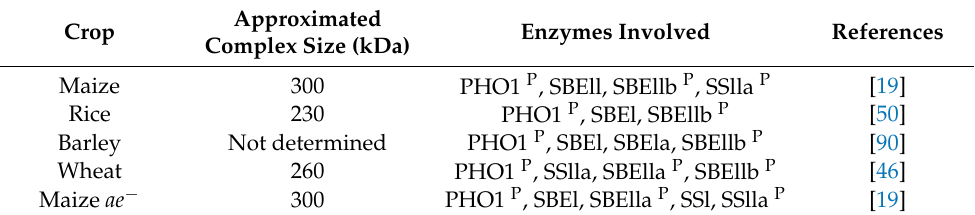
Table 2. Complexes of PHO1 with various starch synthesizing enzymes in the endosperm of ce- real